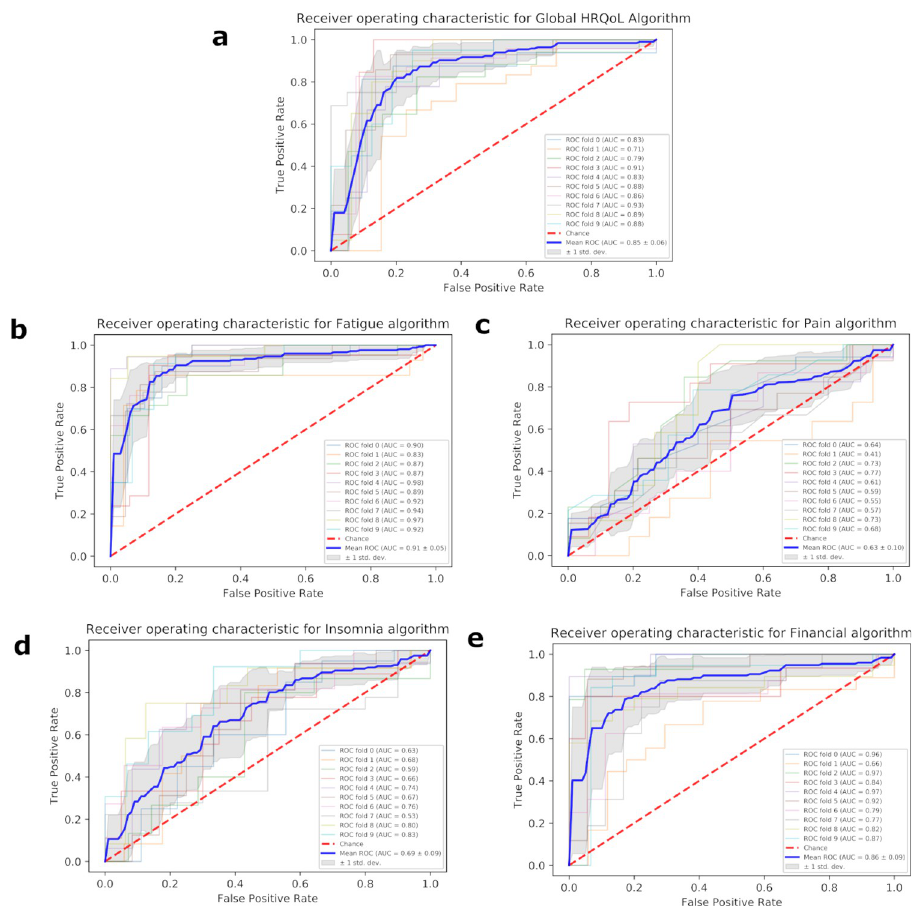
Fig 2. Receiver operating characteristic of the best performing algorithm for the five most prevalent outcome measures in the dataset.